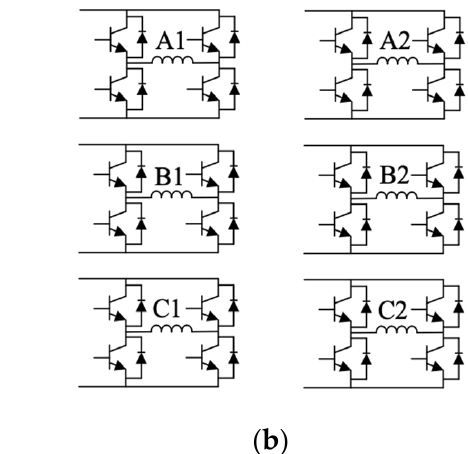
Figure 2. Configuration of two different modular stator segments. ( a ) U-core stator segments and PMs; ( b ) E-core stator segments and PMs.